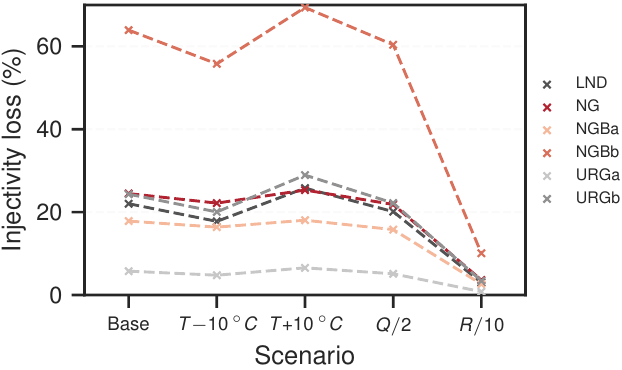
Figure 8. Effective permeability loss after ten years of injecting barite supersaturated fluids into the reservoir. T is the injection temperature, Q is the flow rate and R is the precipitation rate. Note that the connecting dashed lines are only plotted to help distinguish the cases from each